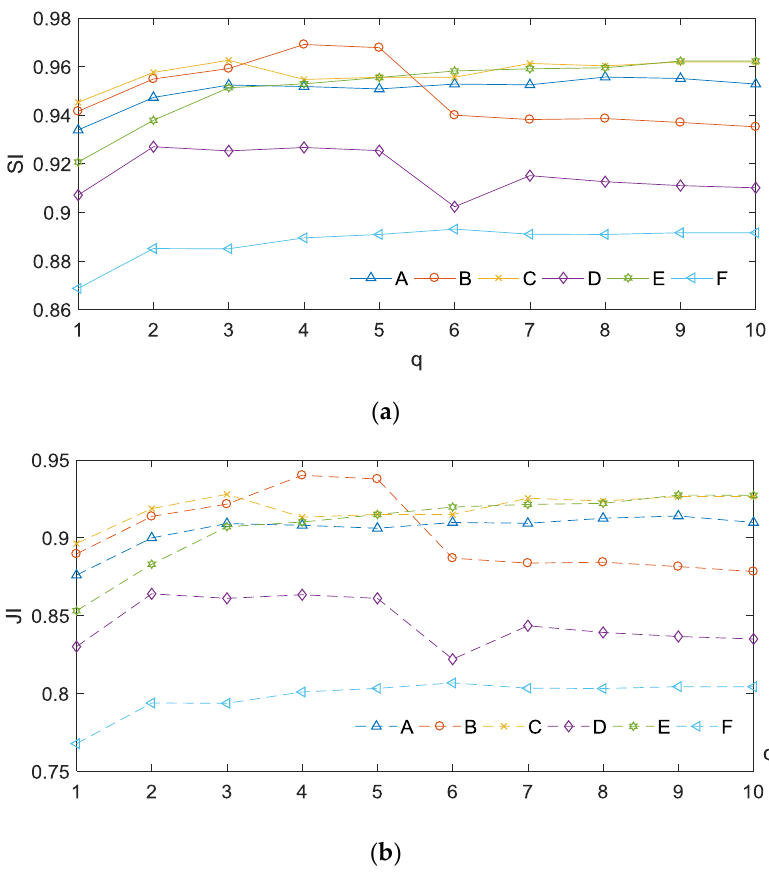
Figure 10. Segmentation accuracy index with different parameter values q ( a ) SI and ( b ) JI. Sensors 2017 , 17 , 1811